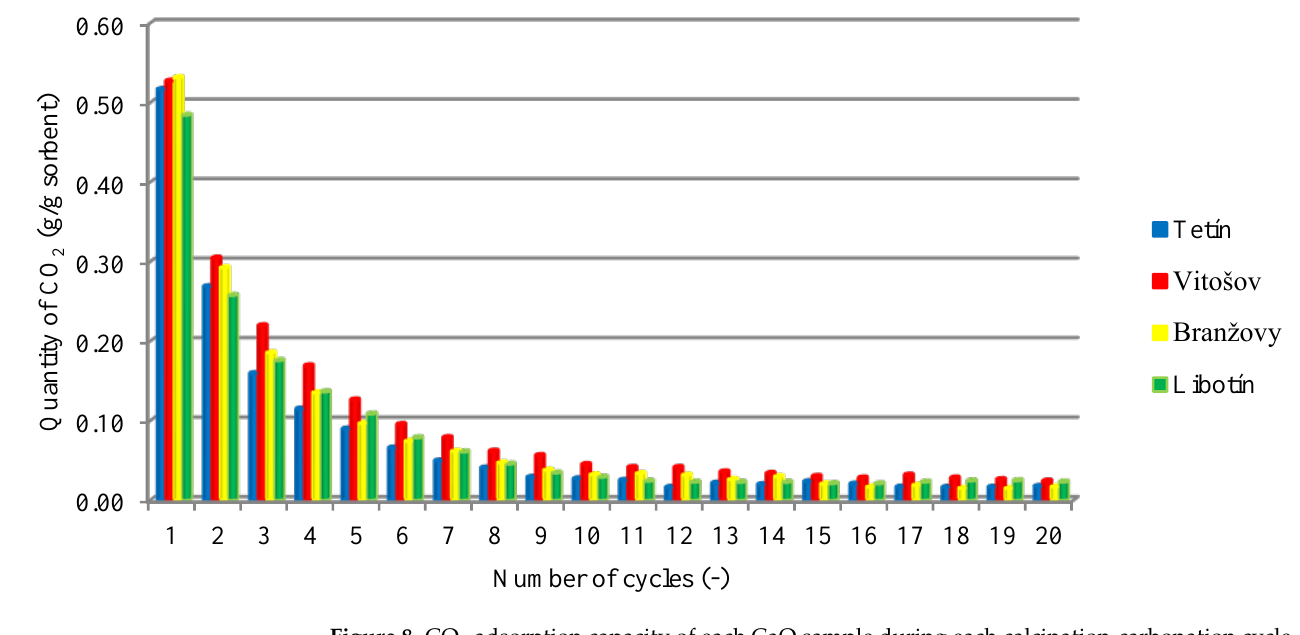
Figure 8. CO 2 adsorption capacity of each CaO sample during each calcination-carbonation